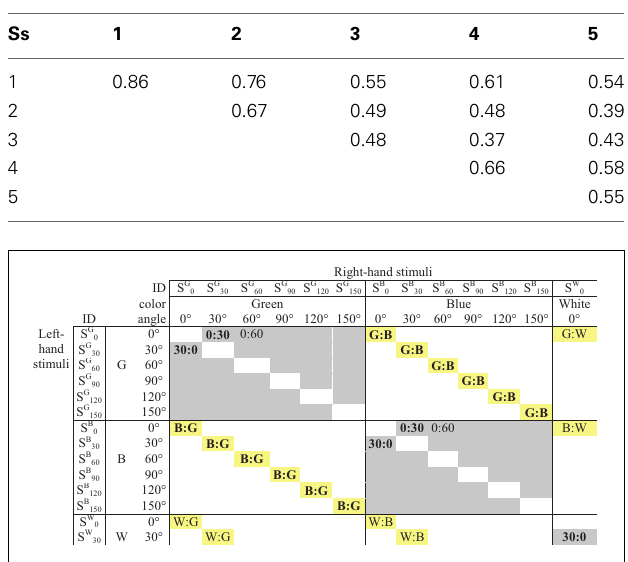
FIGURE 2 | Pairwise comparisons of stimuli created from two attributes (upper left corner of matrix only). Gray cells indicate orientation-only pairs S a m : S a n ; yellow cells indicate color-only pairs S a m : S b m . The Figure shows the 12 pairs averaged for the estimated Green:Blue dissimilarity; five of the 10 pairs averaged to estimate the 30 ◦ :0 ◦ dissimilarity; etc.